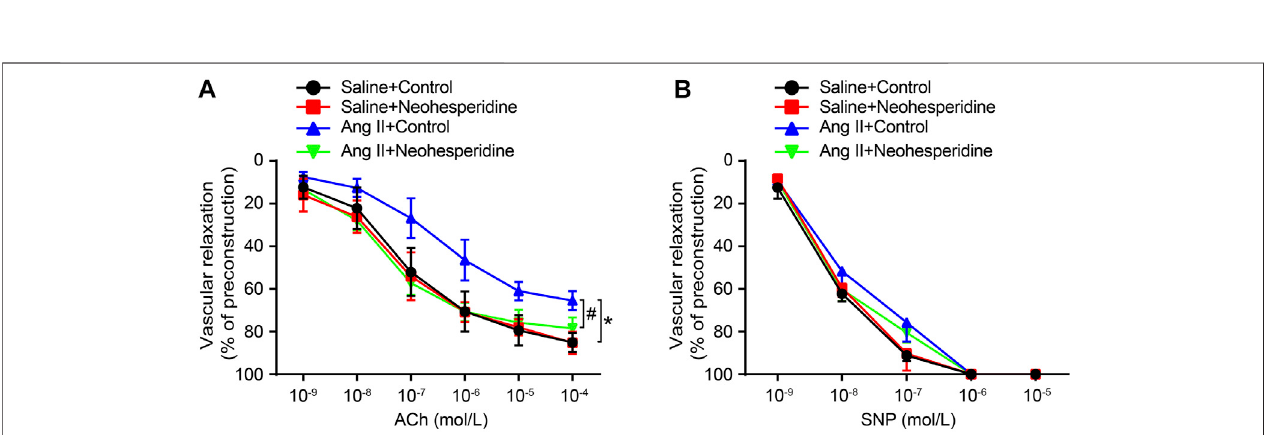
FIGURE 2 | Neohesperidin can prevent endothelial dysfunction induced by Ang II in mice. Mice were infused with Ang II (490 ng/kg/min) by Alzetmodel 1,002 micropump for 2 weeks. A caudal vein injection of Neohesperidin (50 mg/kg/day) was performed for 16 days. Aortic rings were isolated from each group (A) We examinedendothelium-dependentrelaxation inresponse todifferentdosesofacetylcholine( n =6) (B) Weexaminedendothelium-independentrelaxation inresponseto different doses of sodium nitroprusside ( n = 6). Statistical analysis was performed with one-way ANOVA.* p < 0.05, sham vs. Ang II; # p < 0.05, Ang II vs. Ang II +